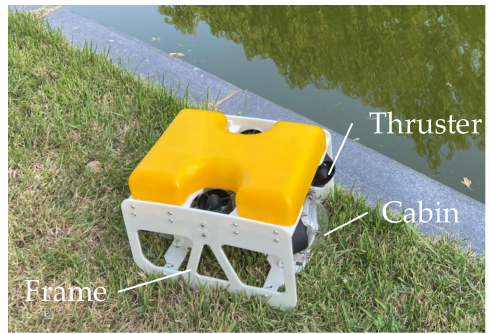
Figure 7. The designed AUV.